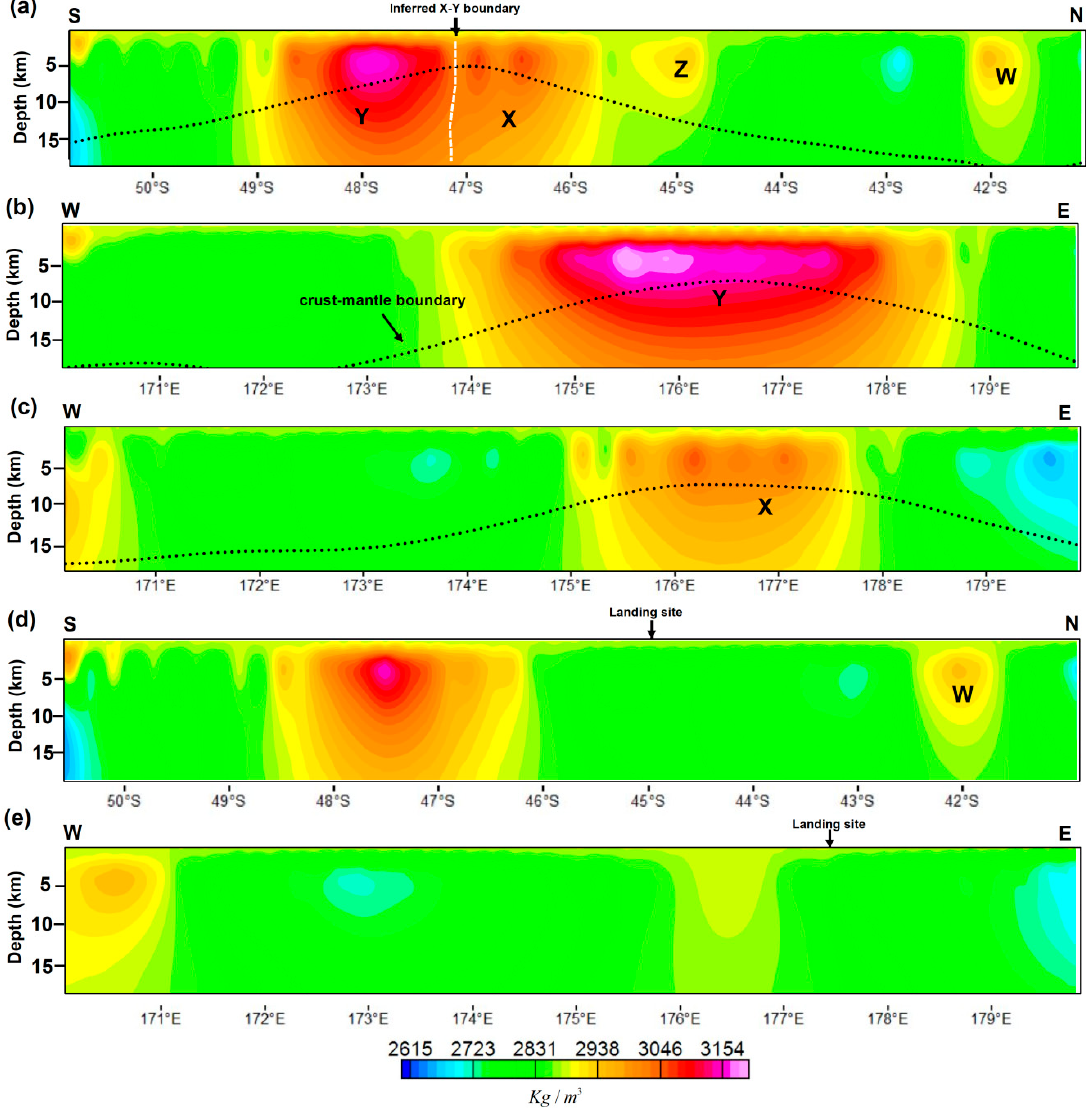
Figure 5. Vertical cross-section maps for the Von Kármán Crater. A vertical cross section, ( a ), ( b ) and ( c ), reveals the subsurface density distribution of locations shown in Figure 4 of the same letters, with a vertical exaggeration of 2. A vertical cross-section, ( d ) and ( e ), indicates the subsurface structure across the landing site (177.59°E, 45.46°S; [11,12]). The black dotted line indicates the crust-mantle boundary from model 2 of Wieczorek et al. [7].